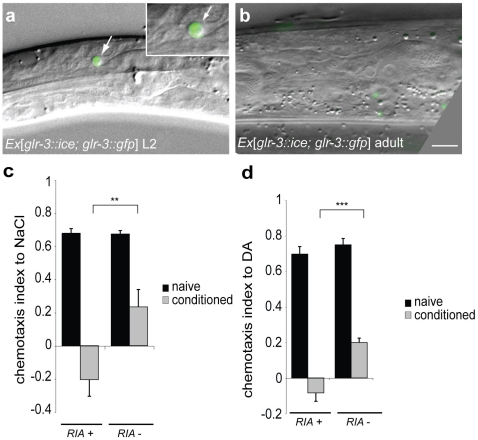
The RIA interneurons are required for associative learning.RIA was genetically ablated by expressing a glr-3 promoter-driven activated ICE caspase. a, expression of the caspase in RIA (labeled with GFP) leads to apoptosis that is characterized by a refractile disc (see also inset) during larval development. b, 59.6% (n = 3200) of the adult worms lack RIA visualized by the missing Pglr-3::gfp reporter expression. Removal of the RIA neuron impairs learning both in c, salt and in d, olfactory associative learning paradigms. For quantitative analysis, three independent experiments were analyzed. Error bars indicate average±S.E.M. Significance between datasets as indicated was tested with two-tailed student's t-test (** p<0.01, *** p<0.001).